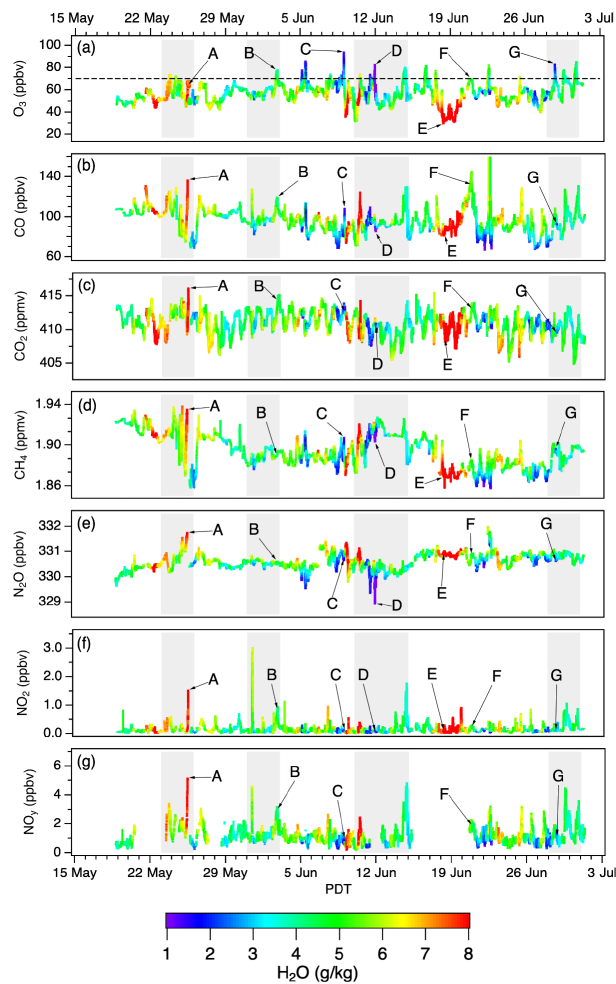
Figure 6. Time series of the AP 1min in situ measurements color- coded by the co-measured H 2 O. The dashed black line in (a) shows the 2015 NAAQS of 70ppbv. The gray regions bracket the four IOPs. The measurements labeled A–G are discussed in the